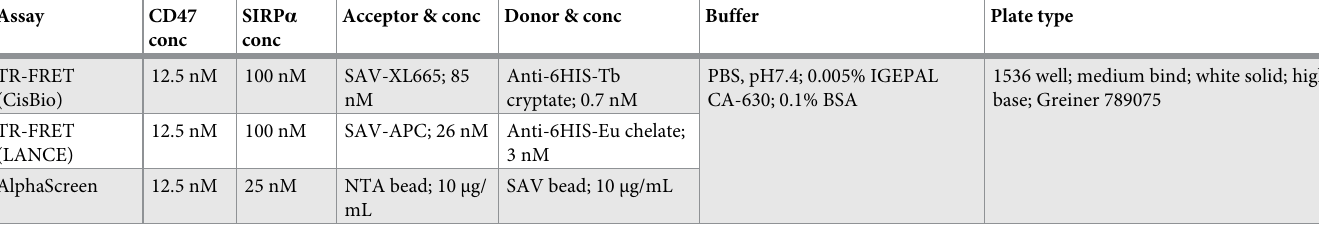
Table 1. Optimized assay conditions for 1536-well plate